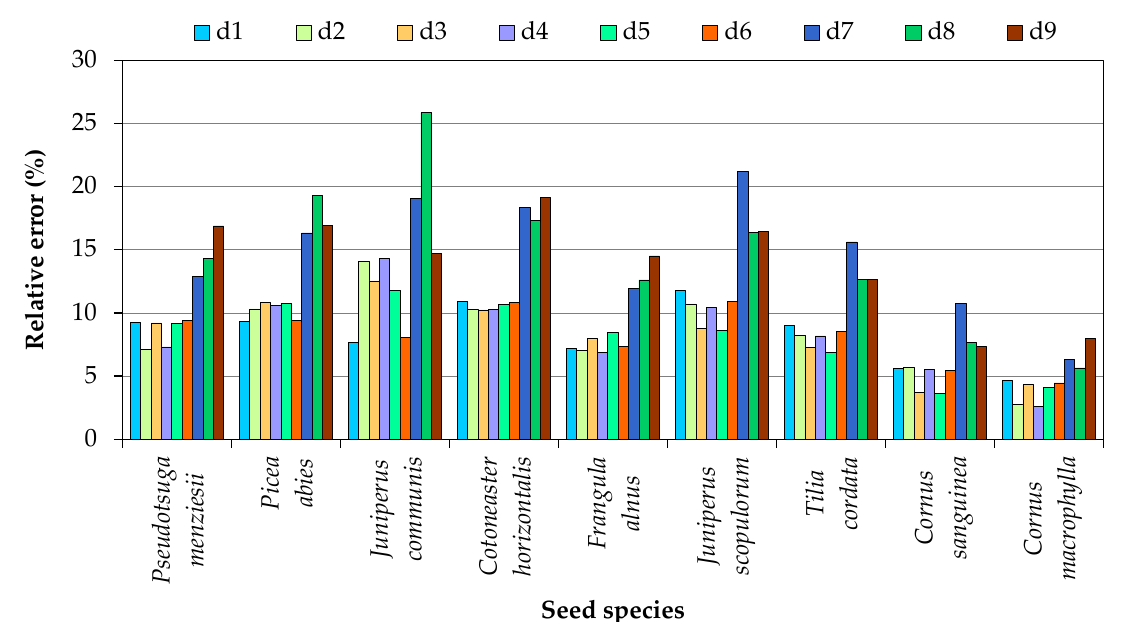
Figure 2. Errors in seed volume calculated with simplified formulas.